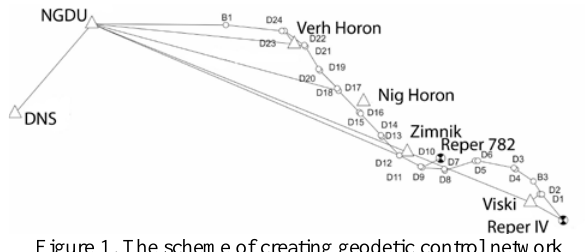
Figure 1. The scheme of creating geodetic control network